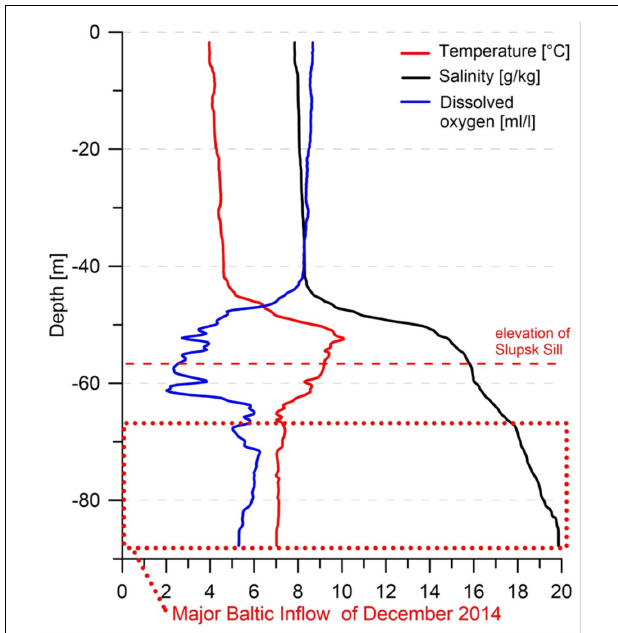
FIGURE 2 | Example of a CTD profile (station B3, Bornholm basin), used to distinguish inflowing from uplifted bottom-water. The dotted line indicates the approximate depth layer of the inflowing water with a higher salinity and oxygen concentration and a lower temperature. Warmer, former bottom-water was uplifted and crossed the Slupsk Channel (dashed line) toward the eastern Gotland